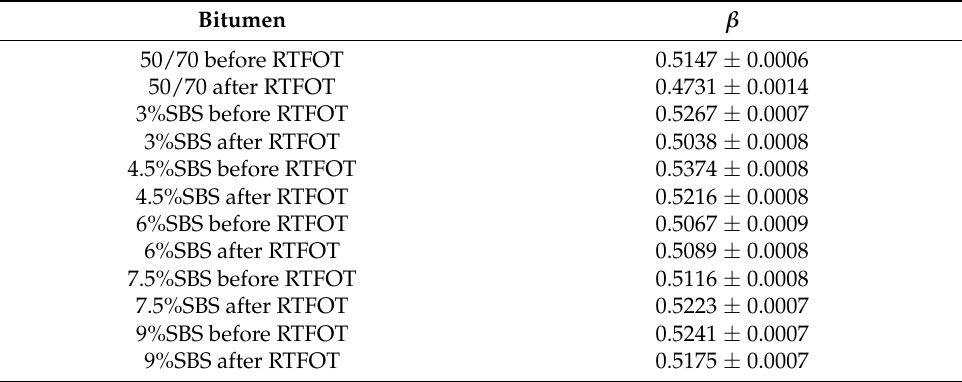
Figure 9. Values of time exponent (parameter β ) in a modified generalized Maxwell model with five parameters. Table 6. Values of β